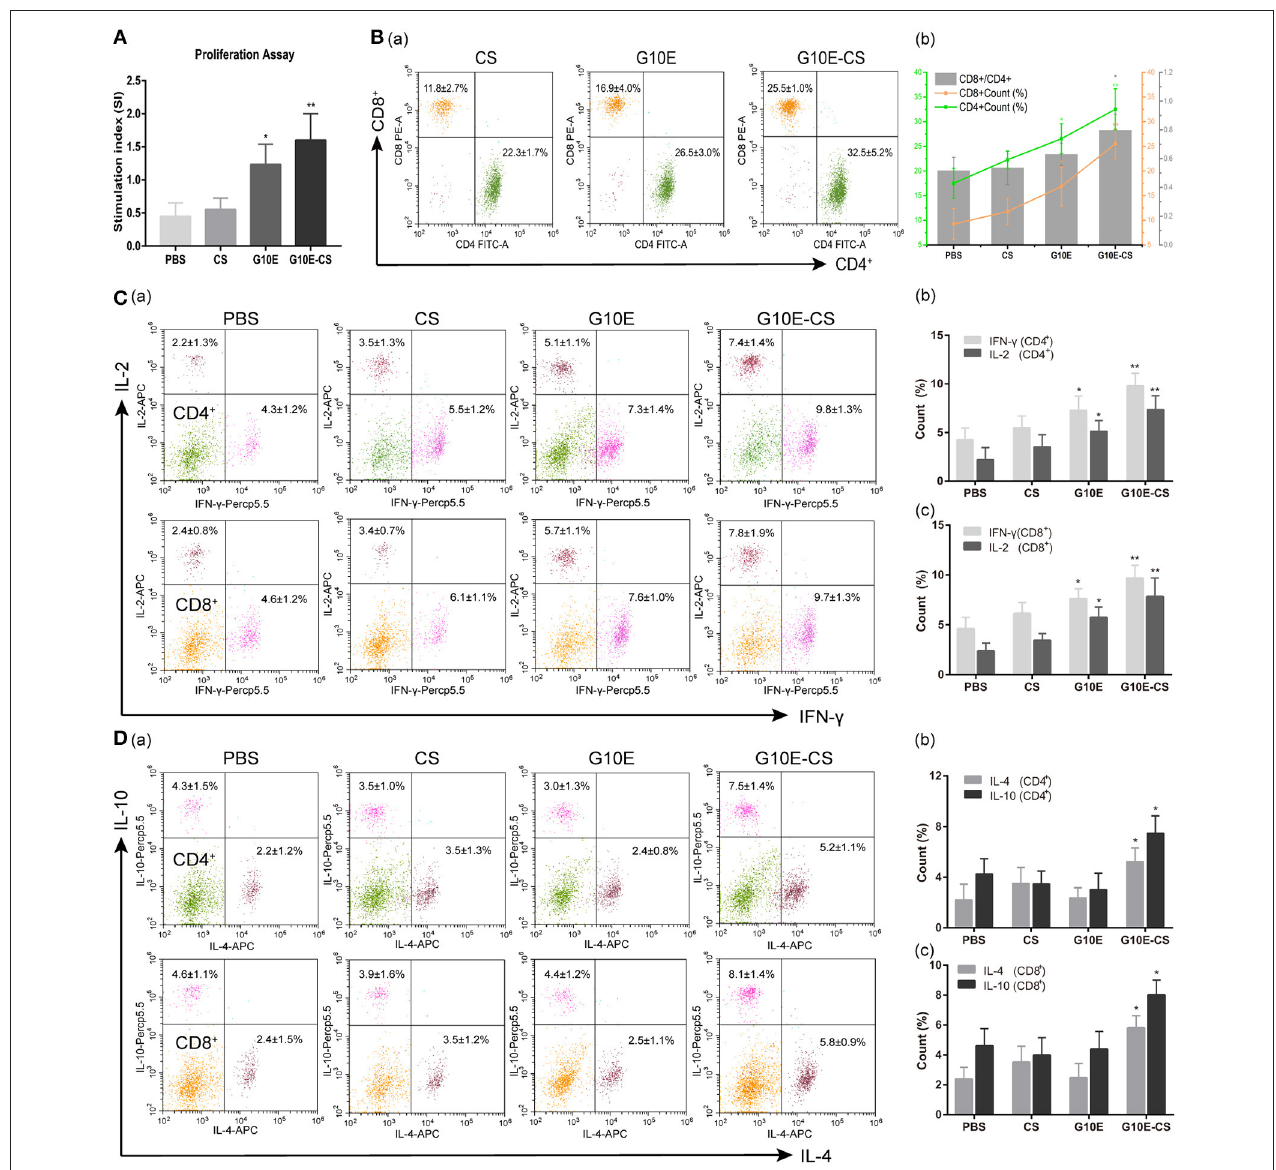
FIGURE 5 | Cellular immune response induced in BALB/C mice after vaccination with G10E-CS. BALB/c mice were immunized with G10E-CS, CS, G10E, or PBS three times at 2-week intervals. Then splenocytes were harvested from three mice per group 2 weeks after the final immunization. Cellular immune responses were analyzed after stimulation with G10E peptides (10 µ g/ml) for 72h. (A) The lymphocyte proliferative response in immunized mice was measured by CCK-8 assay. The absorbance was detected at 450nm and the stimulation index (SI) was calculated. (B) The percentages of T lymphocyte subsets (a) and ratio of CD8 + /CD4 + (b) in immunized mice. The G10E stimulated splenocytes were stained with anti-mouse CD3-APC, anti- mouse CD4-FITC and anti-mouse CD8-PE for 30min and cell population was analyzed by flow cytometry. (C,D) The production of cytokines (IFN- γ , IL-2) (C) and cytokines (IL-4, IL-10) (D) in the immunized mice. The splenocytes were stimulated with G10E peptides for 72h in the presence of Cell Stimulation Cocktail to inhibit the secretion of cytokine into the extracellular and were fixed using an Intracellular Fixation & Permeabilization Buffer Set Kit. After stained with anti-mouse CD4-FITC, anti-mouse CD8-PE, anti-mouse IL-2 (APC), anti-mouse IFN- γ (PerCP-Cyanine 5.5), anti-mouse IL-4 (APC) and anti-mouse IL-10 (PerCP-Cyanine5.5) for 30min, the cells population was analyzed by flow cytometry. Data represent the mean ± SD and splenocytes from three mice in each group were tested individually. * p < 0.05, ** p <